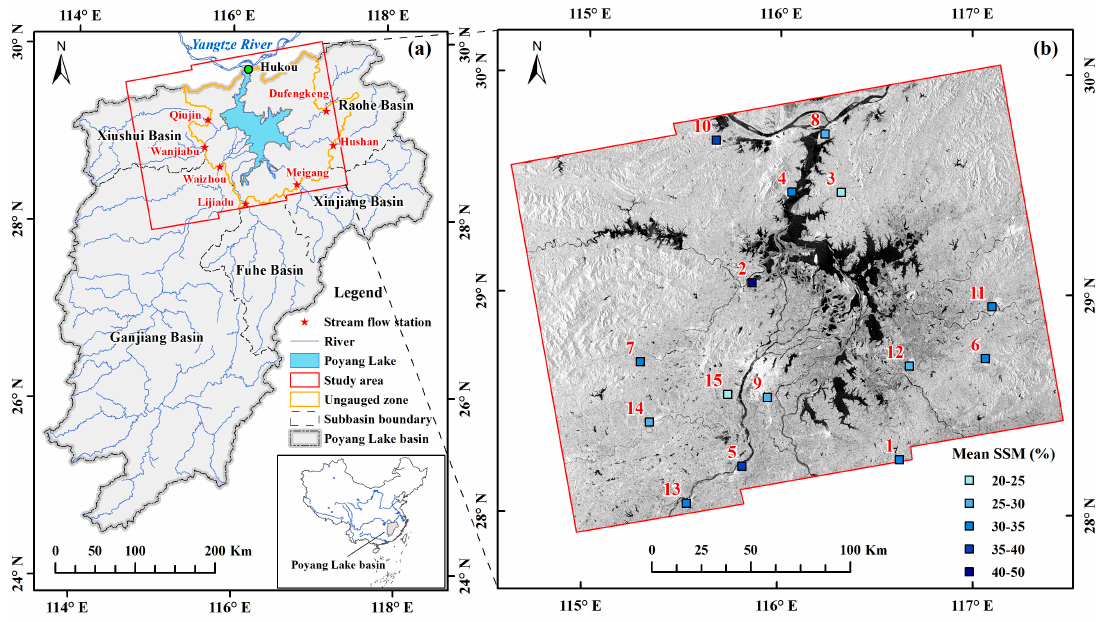
Figure 1. ( a ) Location of the study area and Poyang Lake basin. The lake connects to the Yangtze River at Hukou. The red triangles represent the stream flow stations of five main tributaries, and the yellow polygon shows the boundary of Poyang Lake ungauged zone; ( b ) The preprocessed VV polarized Sentinel-1A image acquired on 18 April 2015, overlaid with the mean surface soil moisture measurements (0–10 cm) of 15 ground monitoring sites.